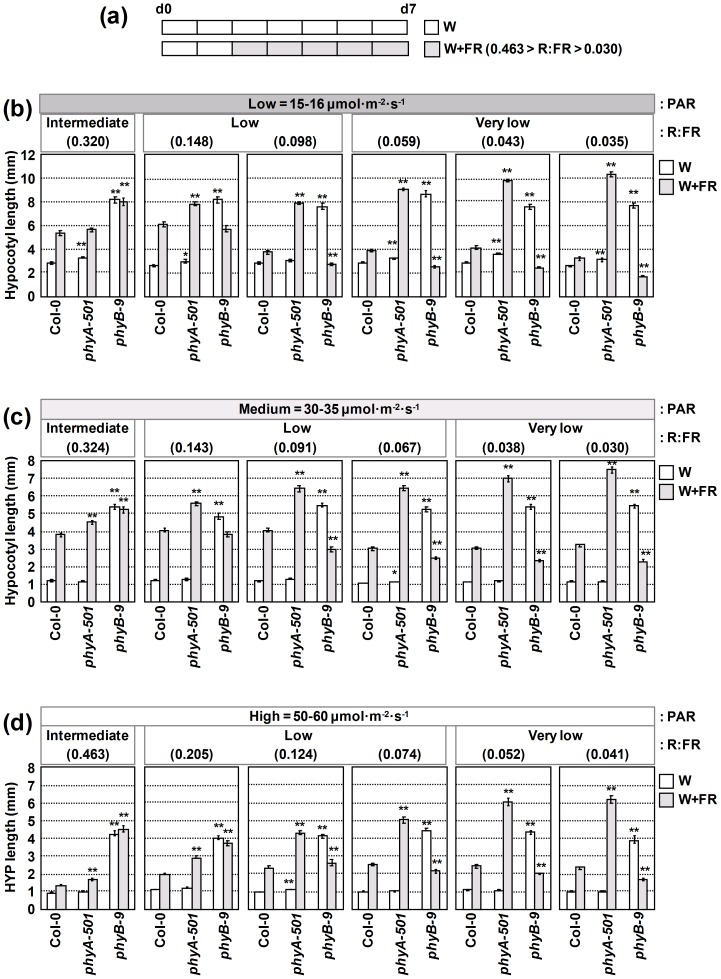
Effect of different R:FR on hypocotyl elongation of wild-type, phyA-501 and phyB-9 seedlings under low, medium or high PAR.(a) Seedlings were germinated and grown for 2 days under W light and then either kept in W or transferred to W supplemented with increasing amounts of FR for 5 more days. Hypocotyl length of seedlings grown as indicated in a under (b) low, (c) medium and high (d) PAR. The amount of PAR is given at the top of each section. The type of R:FR applied (nomenclature provided in Table S1) in the given W+FR treatments is indicated at the top, of the graphs; the R:FR value of each experiment is indicated at the top of each graph. In b, c and d, values are means ± SE of at least 25 hypocotyls for each light treatment. Asterisks indicate significant differences (*P<0.05, **P<0.01) relative to the control (Col-0) grown under the same light conditions.